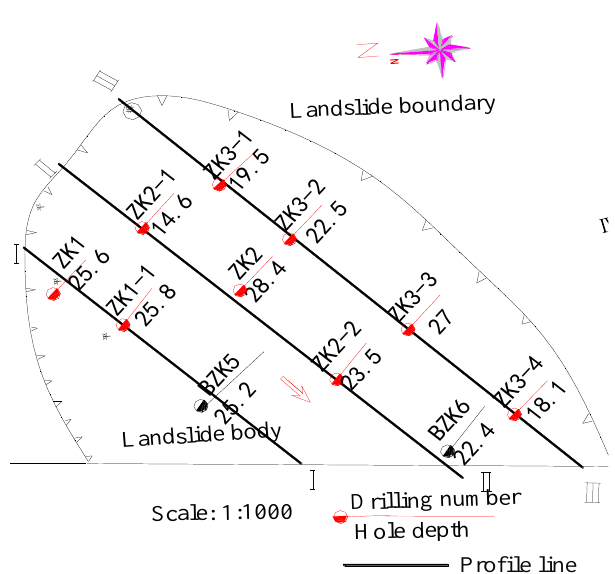
Figure 5. Plane distribution of boreholes.